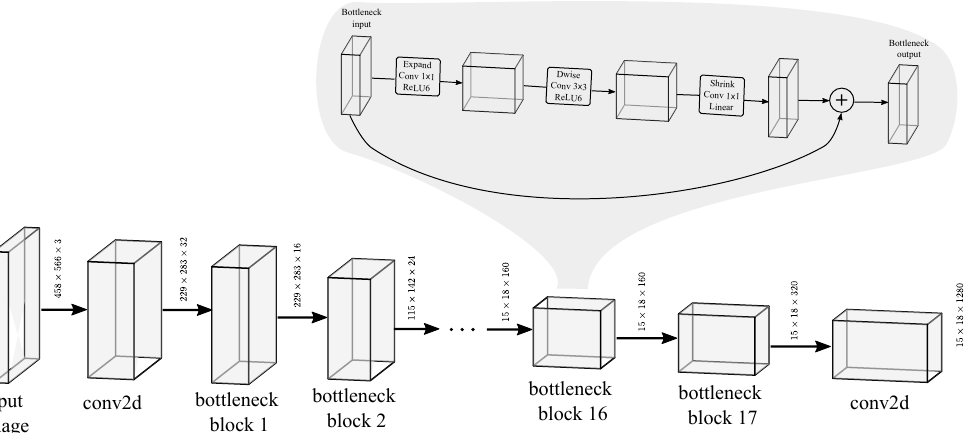
Figure 3. Architecture of MobileNetV2 and bottleneck residual